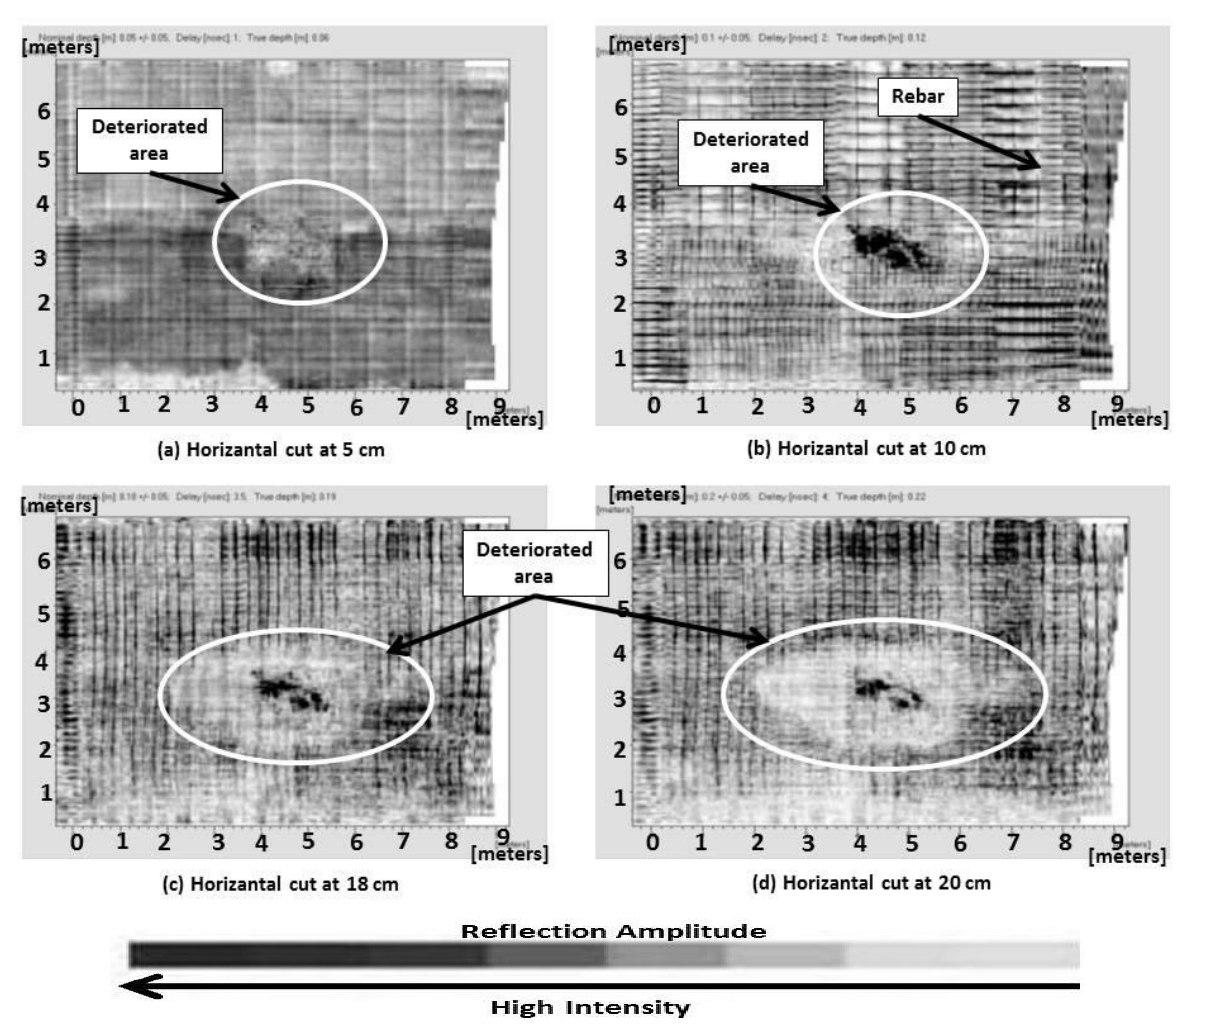
Figure 12. Expansion of the moisture affected area. Horizantal cut at 5cm ( a ) 10cm( b ) 18 cm ( c ) 20 cm ( d ) [37].